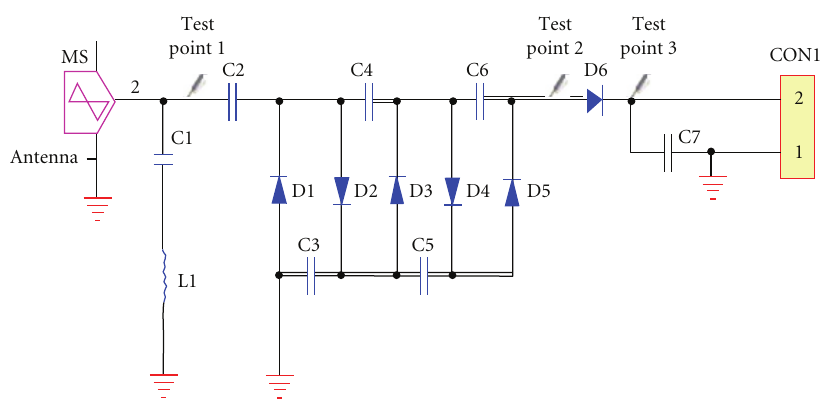
Figure 8: The RF harvester